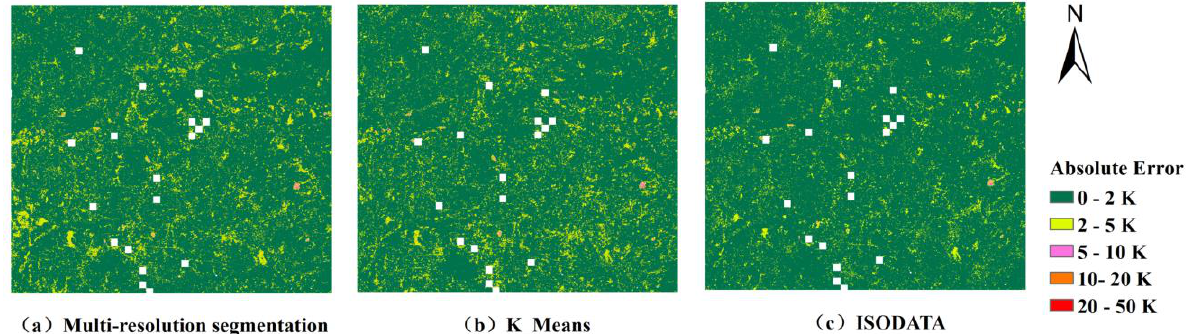
Figure 4. Comparison of absolute error distribution of model fusion results based on multi-scale segmentation ( a ), k-means ( b ) and ISODATA ( c ) on 20 November 2001. The missing pixels are influenced by cloud cover.